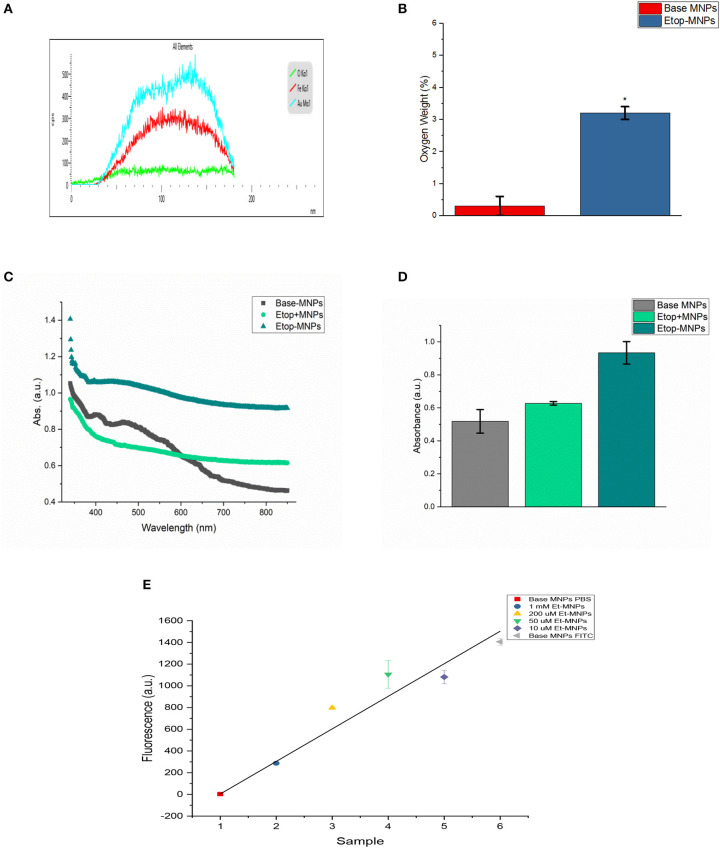
Characterization of Etop-MNPs. (A) Representative EDS data histogram, showing the percentage of weight by element for a single, whole Etop-MNP. (B) Bar graph showing the higher oxygen content of the Etop-MNPs, confirming that etoposide has bound to the base MNPs. (C) UV-visible spectra for base MNPs, a mixture of etoposide with base MNPs and the bound Etop-MNPs, from 340 to 850 nm. (D) Bar graph showing the absorption at 700 nm, which highlights the differences between the particles. (E) FITC loading of various strengths of Etop-MNPs, showing the saturation of binding sites by biotinylated etoposide. For (B,D,E), data are expressed as mean ± SEM with n = 3.